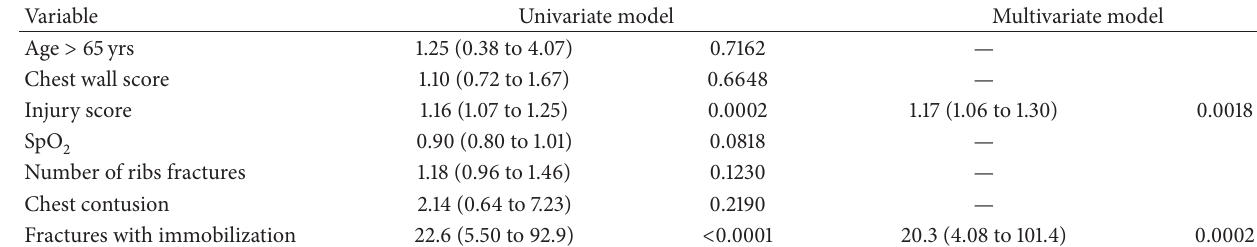
Table 2: Statistical analysis.